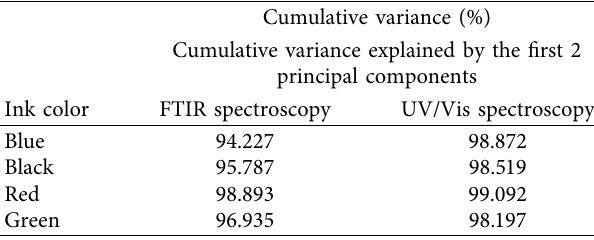
Table 3: Cumulative variance (%) explained by PCA of ballpoint pen inks.